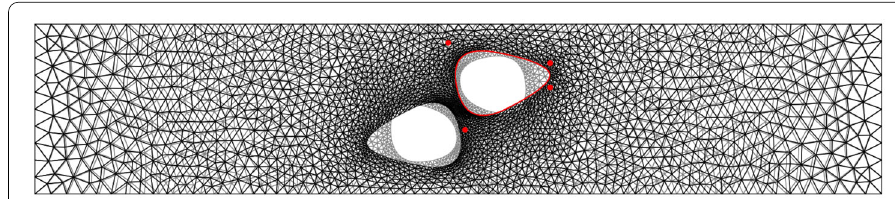
Fig. 14 Example of the orthotropic plate with two holes: improved geometry after the second optimization run (in black) compared to the optimal shape obtained after the first optimization run (in grey), and corresponding 1D-FFD morphing box and its control points position (in red)